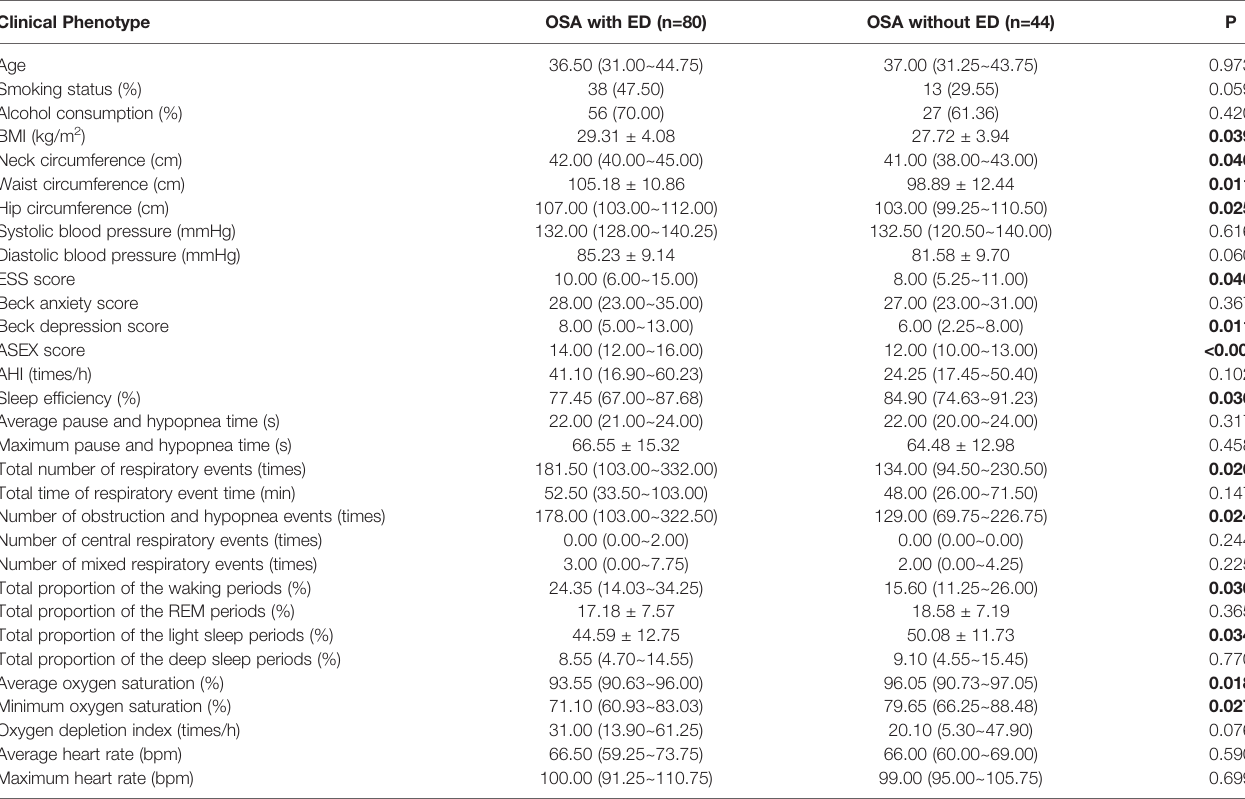
TABLE 4 | Basic demographics and related clinical phenotypes of OSA with ED and without ED. Clinical